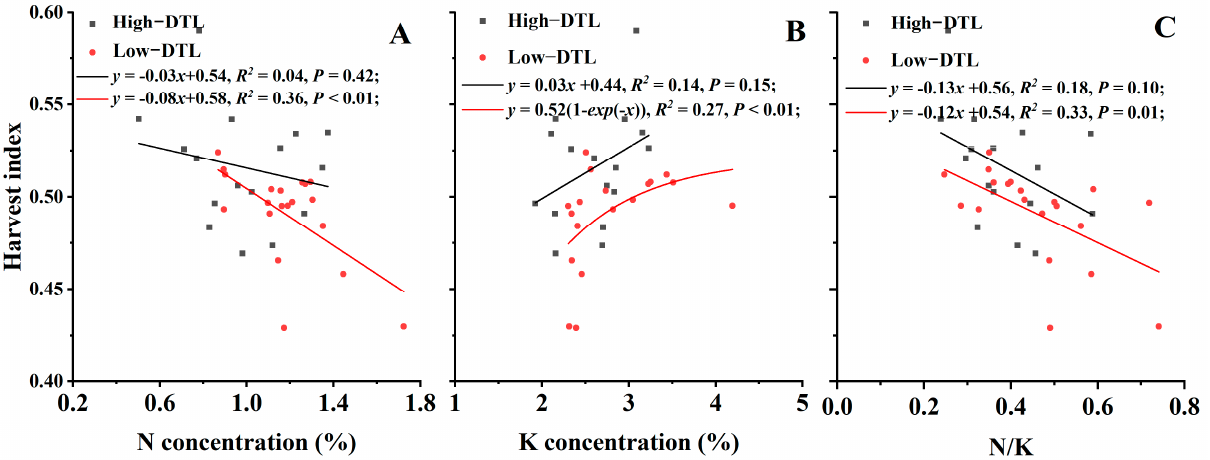
Figure 4. Regression analysis between the harvest index and the concentrations of N (A) and K (B), and N/K (C) in vegetative organs. Note: High-DTL: High daytime temperature and light after heading; Low-DTL: Low daytime temperature and light after heading.